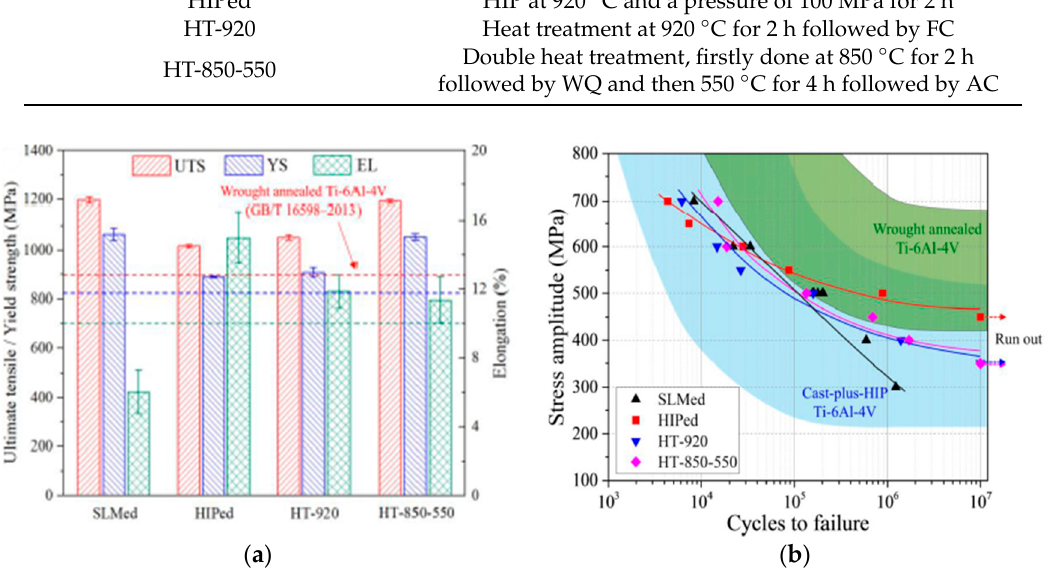
Figure 11. ( a ) Tensile properties and elongation of the different specimens, ( b ) Fatigue performances of the distinct specimens. Adapted from [73], with permission of Elsevier, 2019.